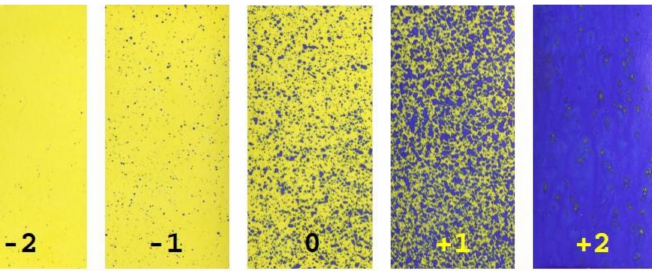
Figure 3. Example of the scores (from − 2 to +2) assigned to the water sensitive papers by visual rating, according to the quality of the coverage. A score equal to zero is an ideal quality coverage.